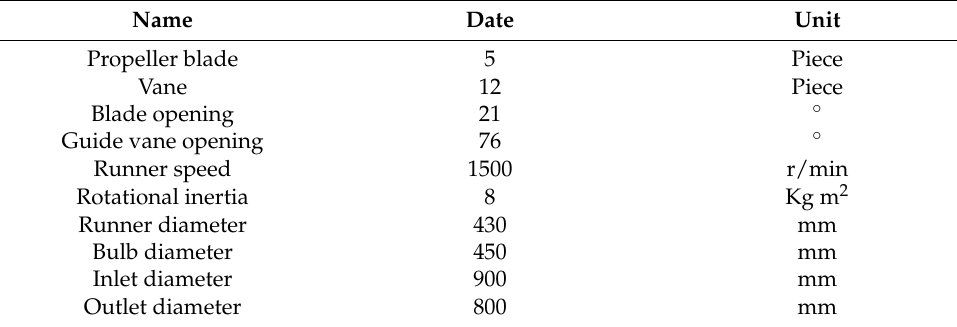
Table 1. Geometric parameters of the bulb turbine.